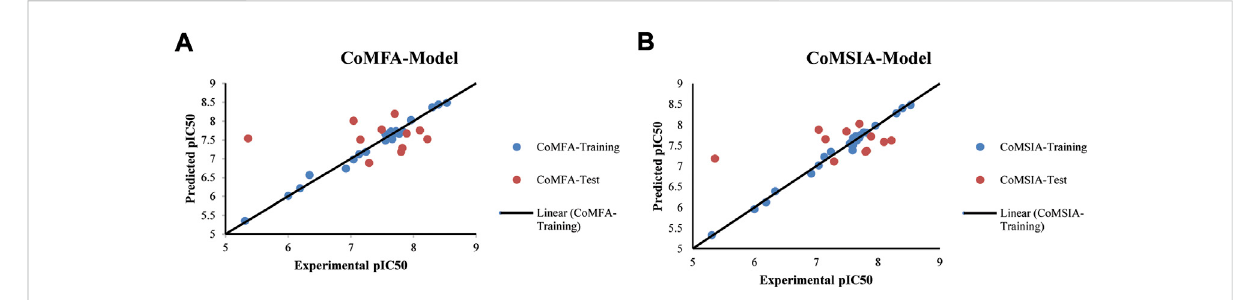
FIGURE 2 Correlation plots between experimental and predicted biological activities (A) From CoMFA Model (B) From CoMSIA